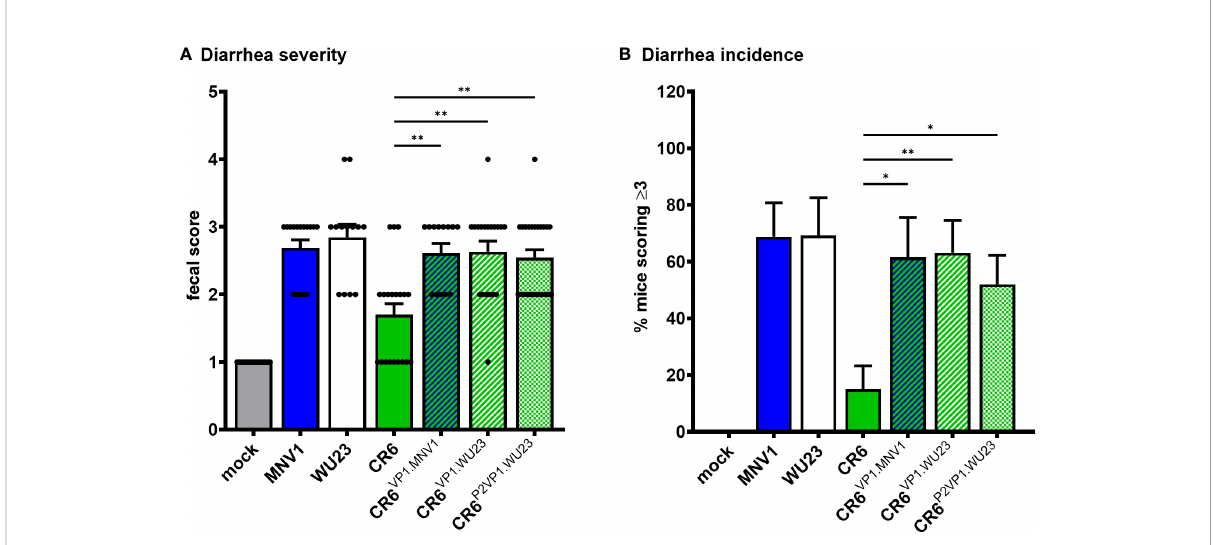
FIGURE 3 VP1 is the major MNV virulence factor in C57BL/6J mice. Groups of P3 B6 pups were inoculated with 10 7 TCID 50 units of mock inoculum, MNV1, WU23, CR6, or the indicated chimeric virus. (A) Fecal consistency was determined at 2 dpi by palpating their abdomens. (B) The proportion of mice scoring a 3 or above is presented as incidence of diarrhea. At least thirteen mice from a minimum of two different litters per condition were analyzed. Error bars denote standard errors of mean in all fi gures. P values were determined using Kruskal-Wallis test with Dunn ’ s multiple comparisons test comparing all groups to CR6. *P < 0.05, **P <